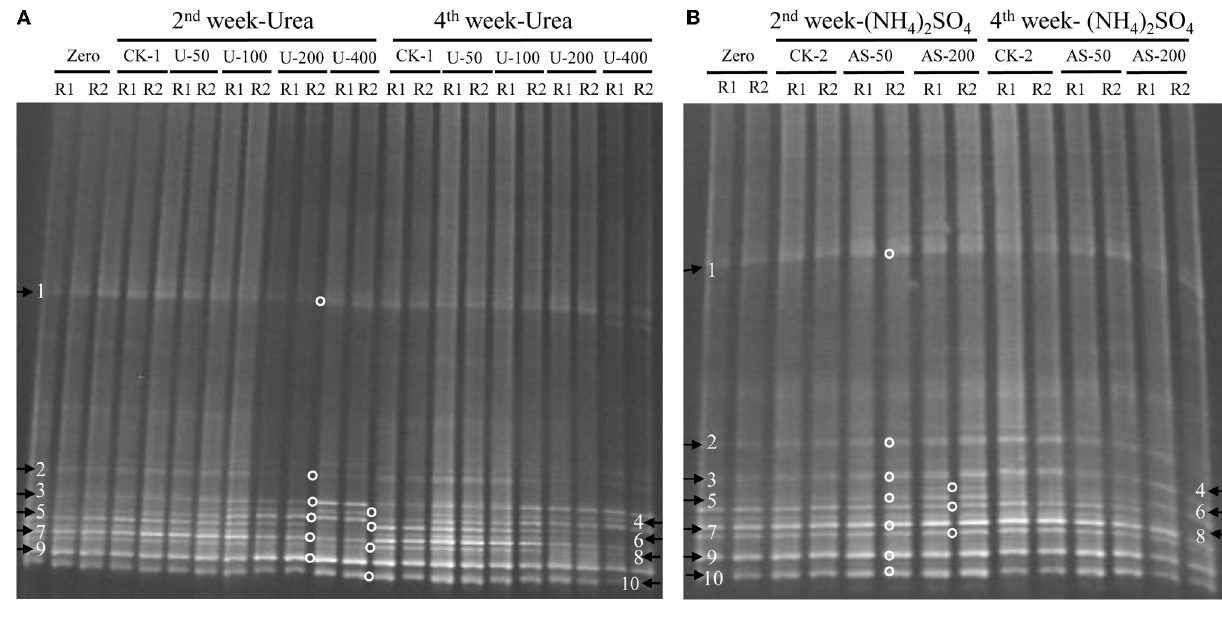
sequencing. Zero represents the original soil sample, and all other designations are the same as in Figure 1 . R1 and R2 represent duplicate microcosms.